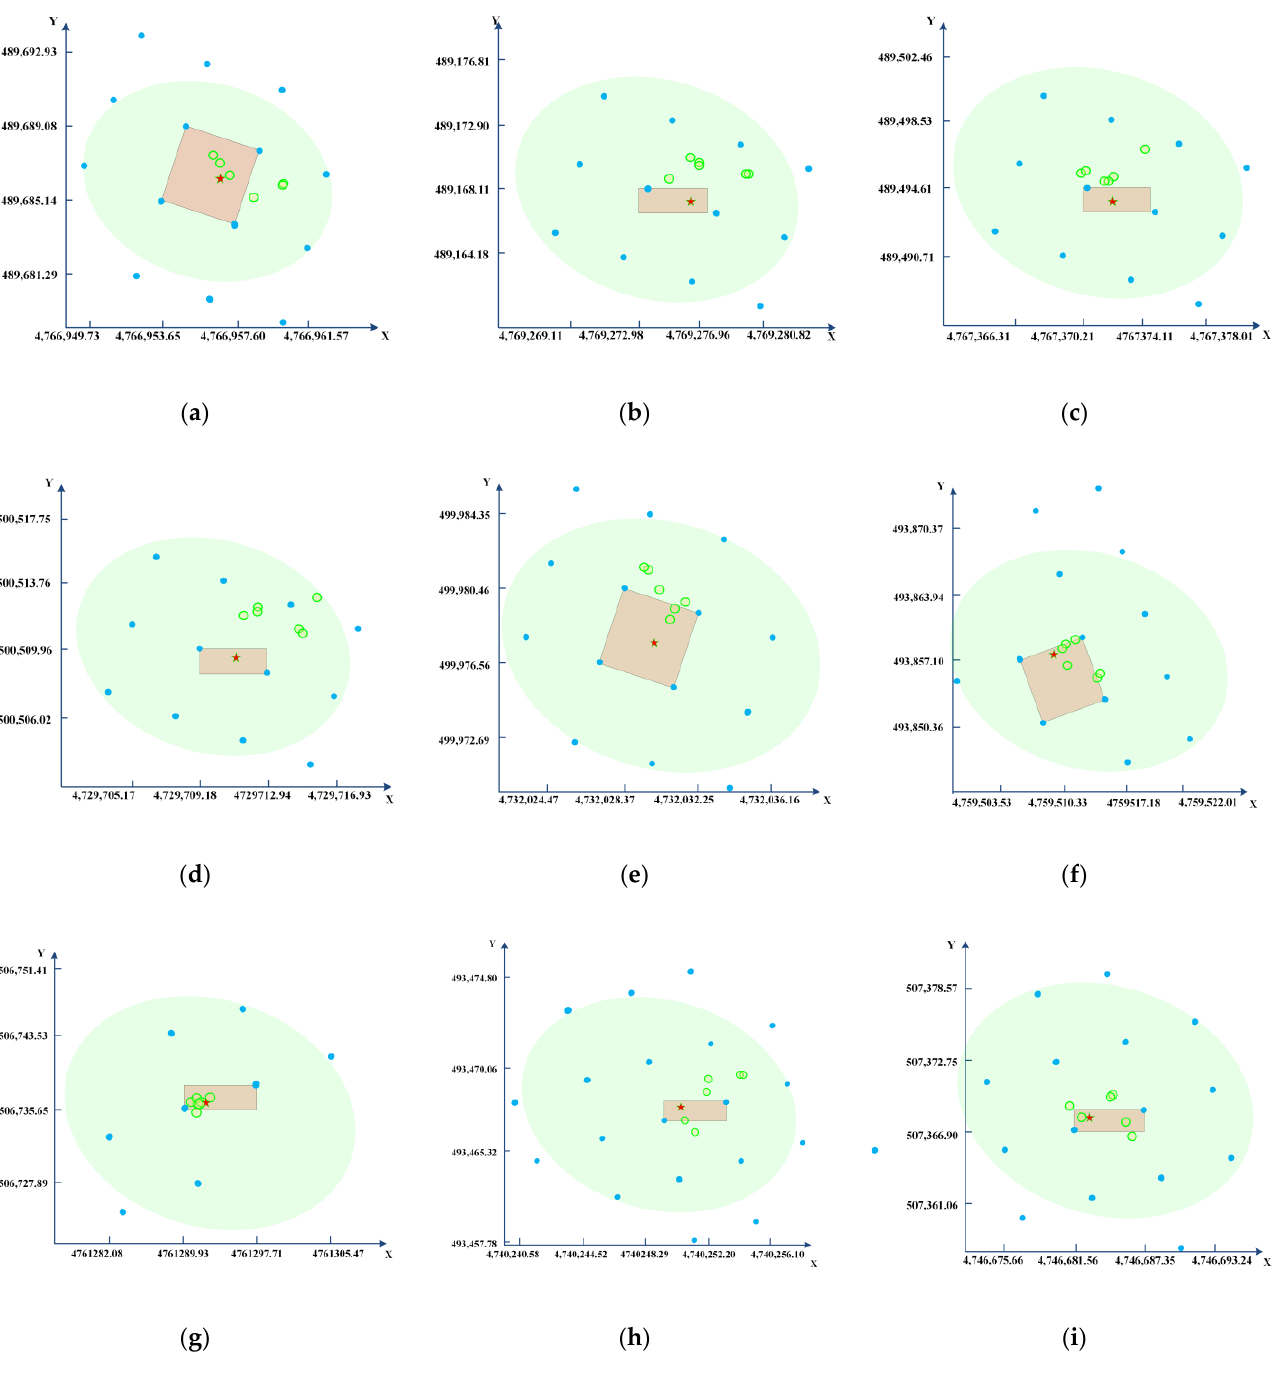
Figure 9. Spatial relationship of scopes in which centroids positioned using different methods and centroid truth values might appear (the light green ellipse represents the schematic diagram of the spot captured by the infrared detector array; the rectangle is the scope in which the centroid truth values might appear; star represents the centroids positioned with the method proposed in this paper; circular dots represent the centroids positioned by other six methods; points distributed in arrays are detectors). ( a ) 241,743,151.00, ( b ) 241,743,151.33, ( c ) 242,175,041.00, ( d ) 243,038,830.00, ( e ) 243,038,830.33, ( f ) 203,600,254.00, ( g ) 203,600,253.33, ( h ) 204,032,177.00, ( i ) 204,032,175.67.